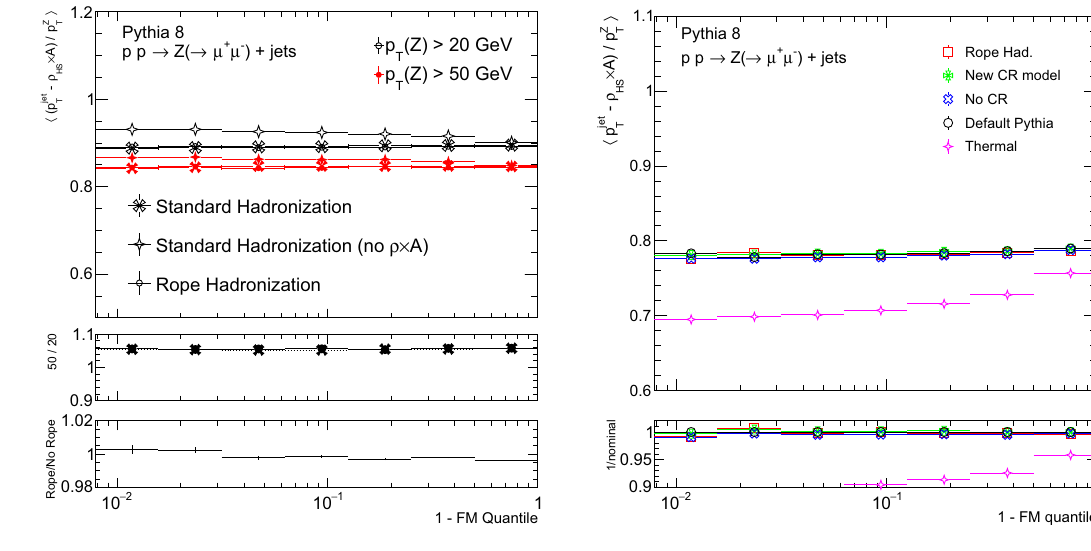
with a dashed line, rope with solid), both including the areas correction. Finally, the lower panel shows the ratio between the rope and standard hadronization models with the p T , Z > 20GeV requirement and both with the areas correction. The corresponding plots for TTM and ZTM are in the appendix, Fig. 18. The right plot shows similar information for the single p T ( Z ) > 20GeV threshold and multiple